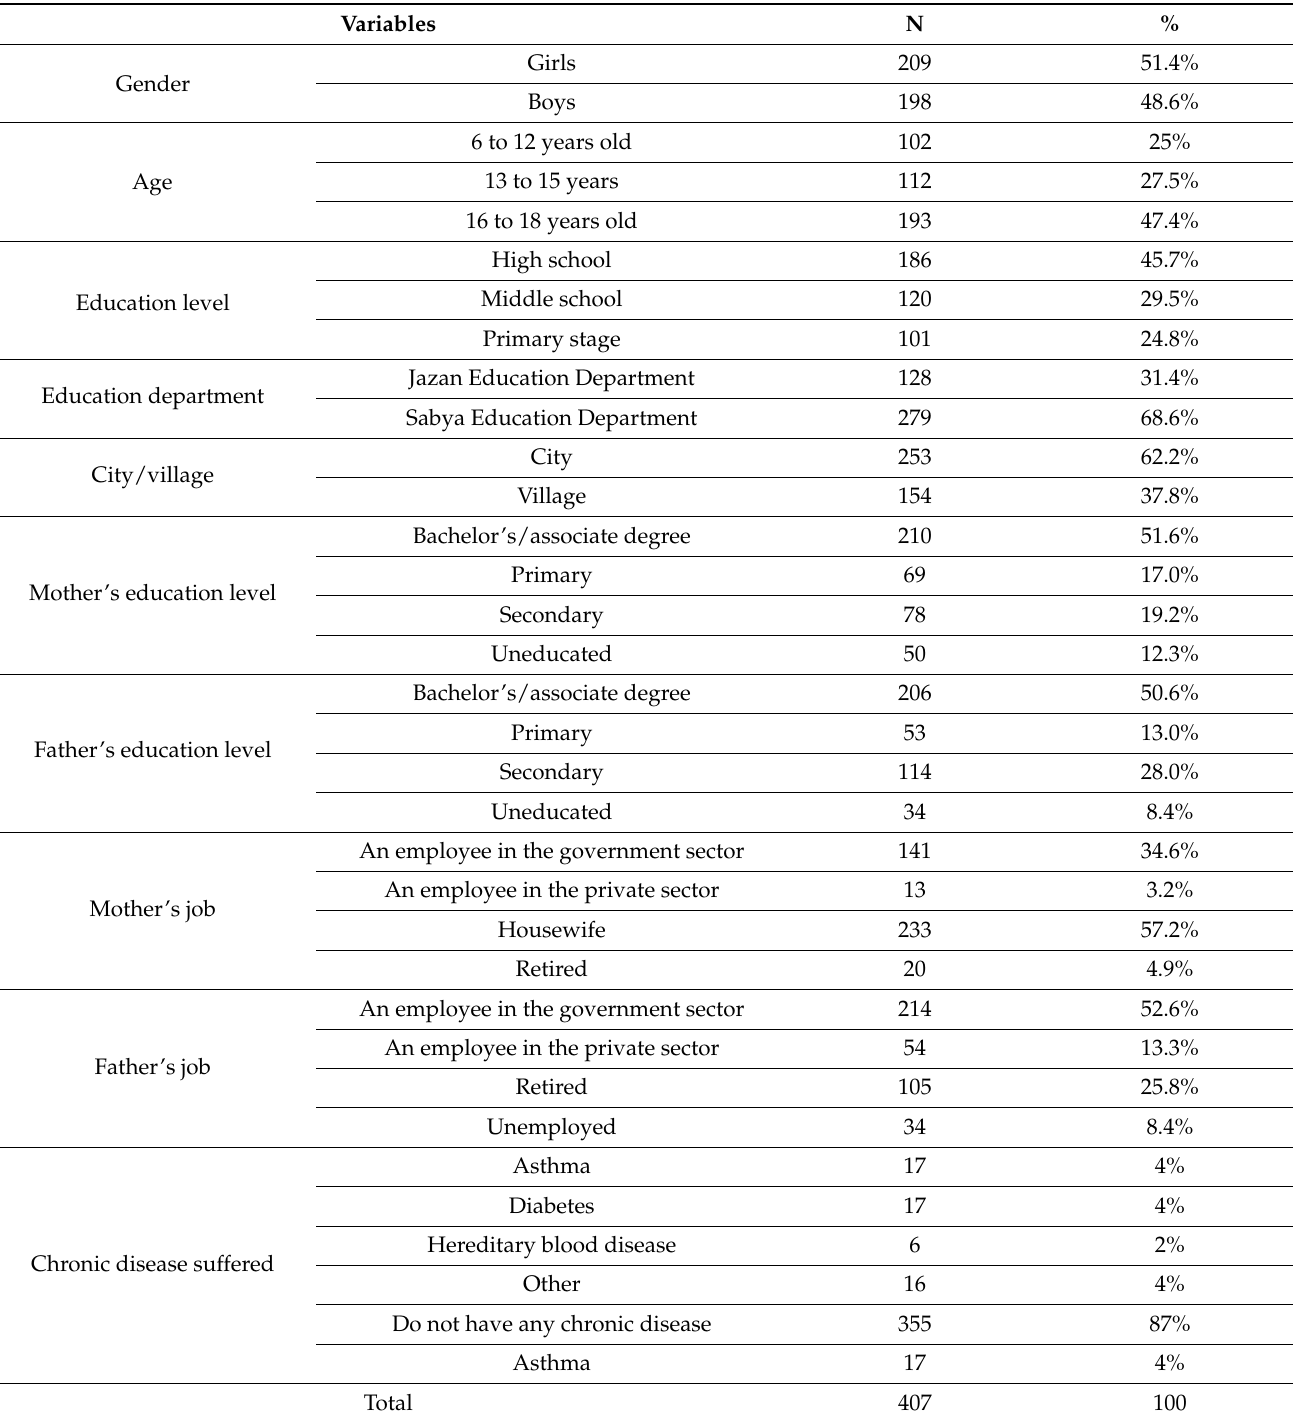
Table 1. Demographic characteristics of the study